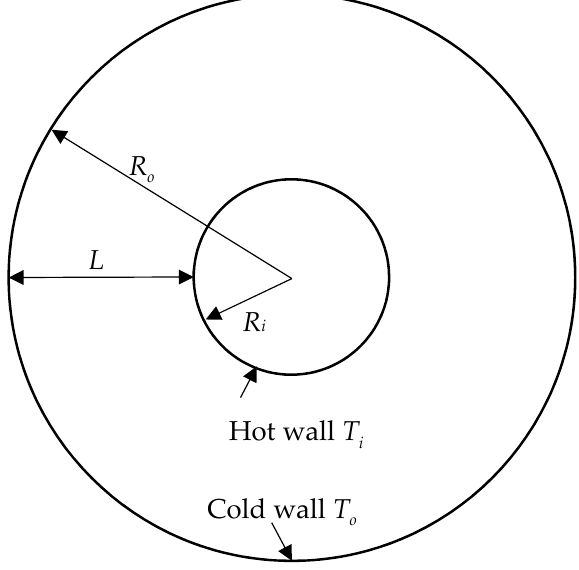
Figure 6. Illustration of the setup for natural convection in a concentric annulus.